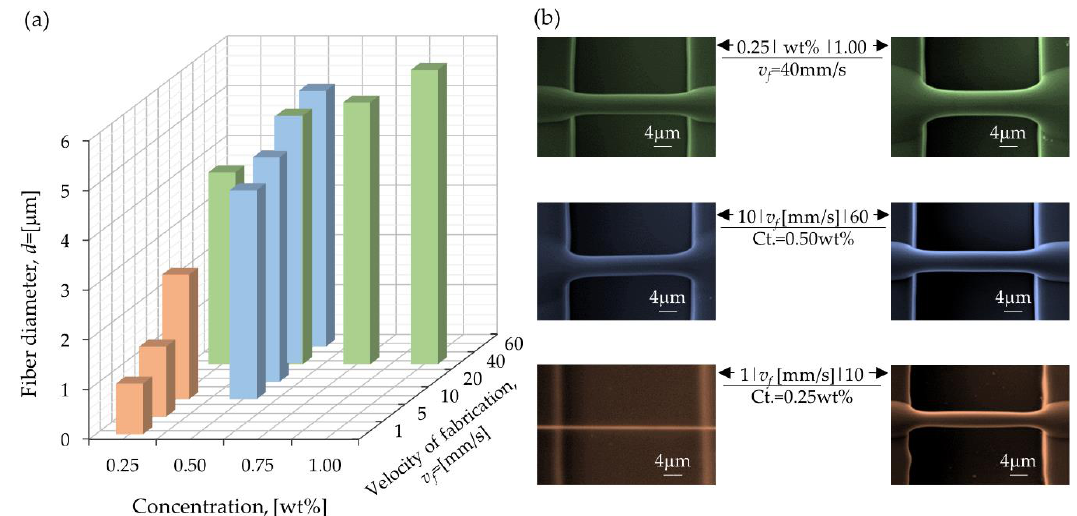
Figure 8. ( a ) Average diameter of fibers for all the experiments varying velocities of fabrication and concentrations of [PEO] = [TBATFB]. ( b ) SEM images of the fibers for the highest and lowest values of concentrations or velocities.